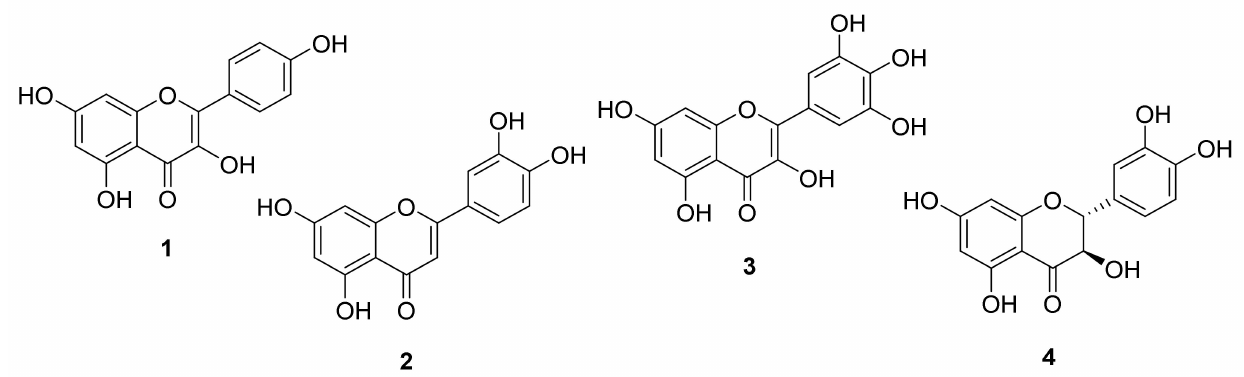
Figure 2. Chemical structures of the isolated compounds from